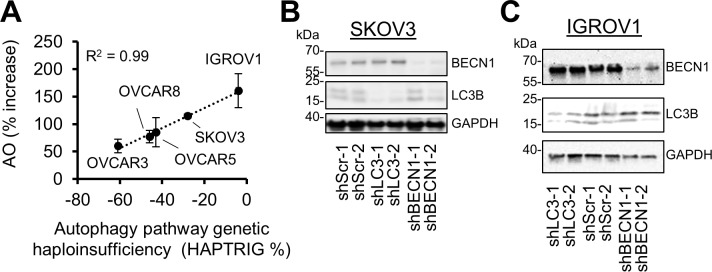
Titrated knockdown of BECN1 or LC3B reduces autophagosome accumulation markers.A, Commonly used ovarian cancer cell lines were tested for acidic vacuole accumulation following chloroquine treatment (10μM 24h) by flow cytometric measurement of acridine orange (AO). Shown are the averages of 4 flow cytometry assays. The x-axis depicts a pathway network calculation from HAPTRIG defining the levels of autophagy pathway haploinsufficiency within each cell line due to monoallelic losses of KEGG autophagy pathway genes. B, SKOV3 cells, which do not have losses in BECN1 nor LC3B, were stably knocked-down by shRNA lentivirus. A western blot was performed for the targets LC3B and BECN1, along with GAPDH loading control. C, IGROV1 cells were similarly assayed.